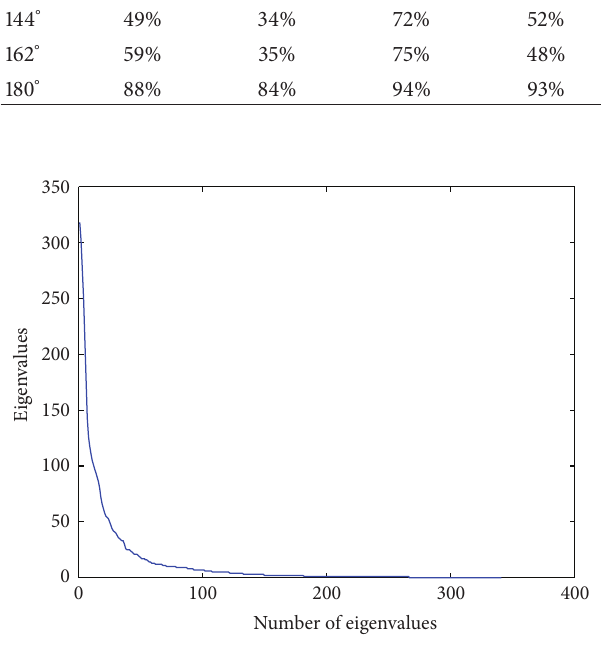
Figure 4: The magnitude of eigenvalue.